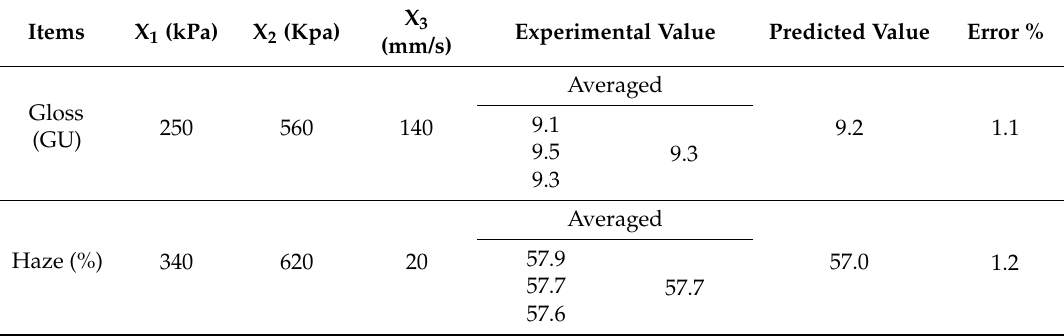
Table 6. The measured optimal condition of lowest gloss and highest haze, and the predicted ones from Equations (3) and (5),